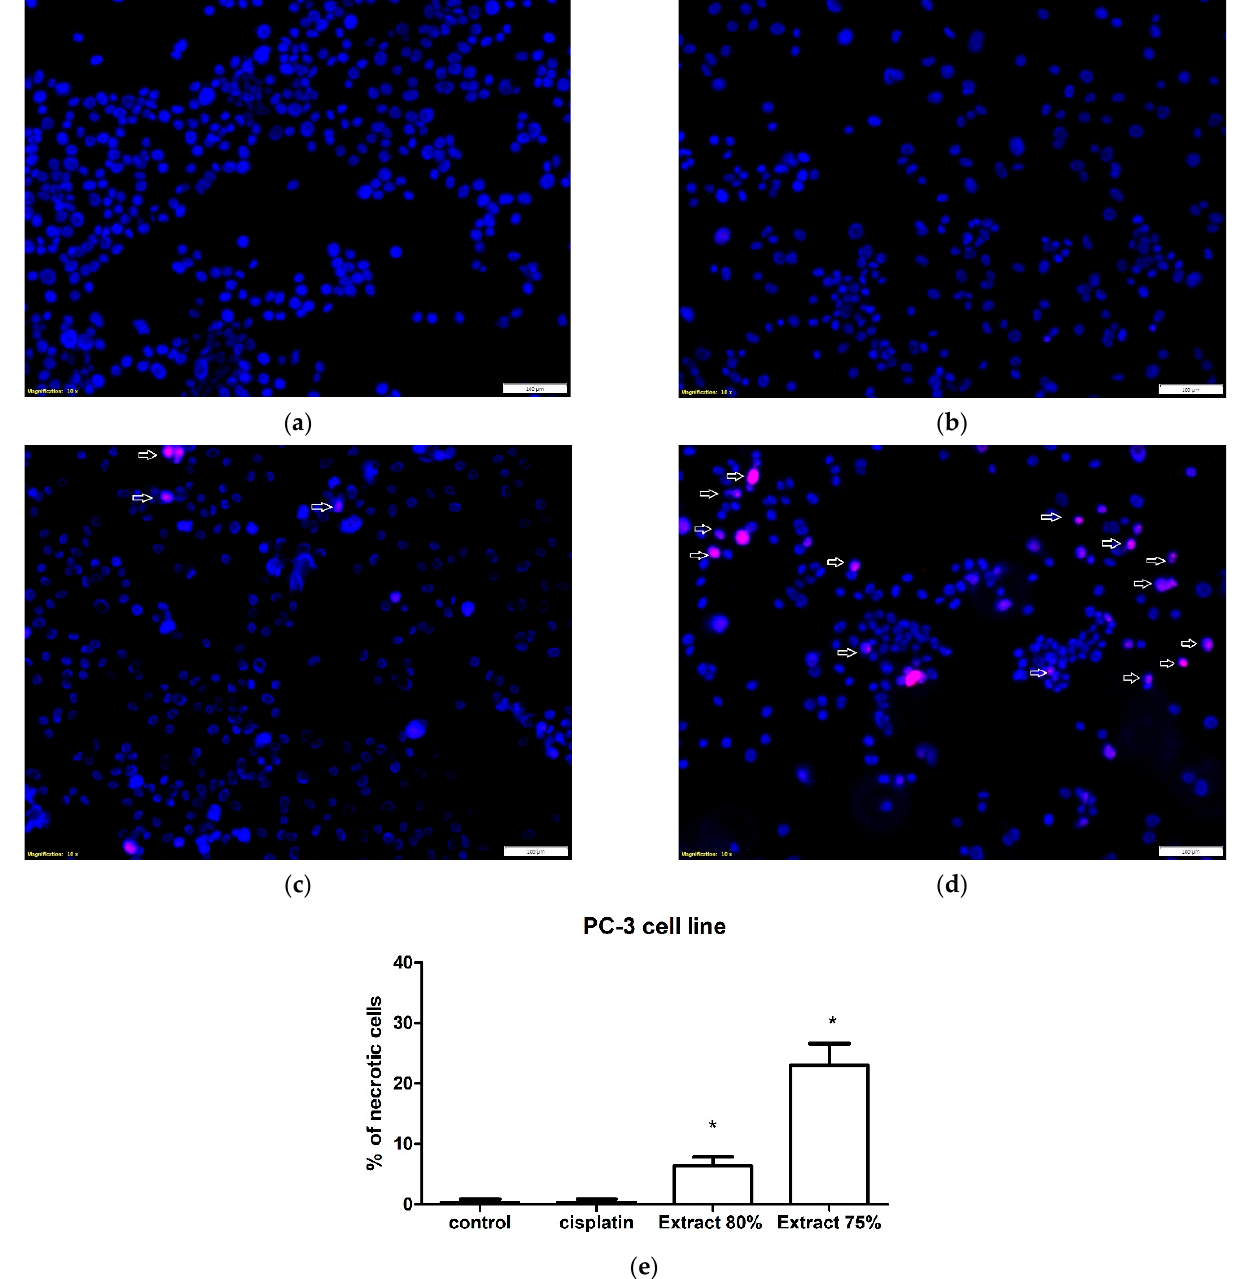
Figure 4. Effects of the tested extracts on the induction of PC-3 cell death: ( a ) control; ( b ) cisplatin at 25 µg/mL; ( c ) 80% extract at 25 µg/mL; ( d ) 75% extract at 25 µg/mL. Propidium iodide (red) and Hoechst 33342 (blue) staining. Magnification, 10×. Necrotic cell nuclei were stained pink. The number of necrotic cells per 100 PC-3 cells was assessed in three visual fields. Data are presented as means ± SDs. Significant values (*) compared with control with p < 0.05 (one-way ANOVA with Tukey’s post hoc test) ( e ).